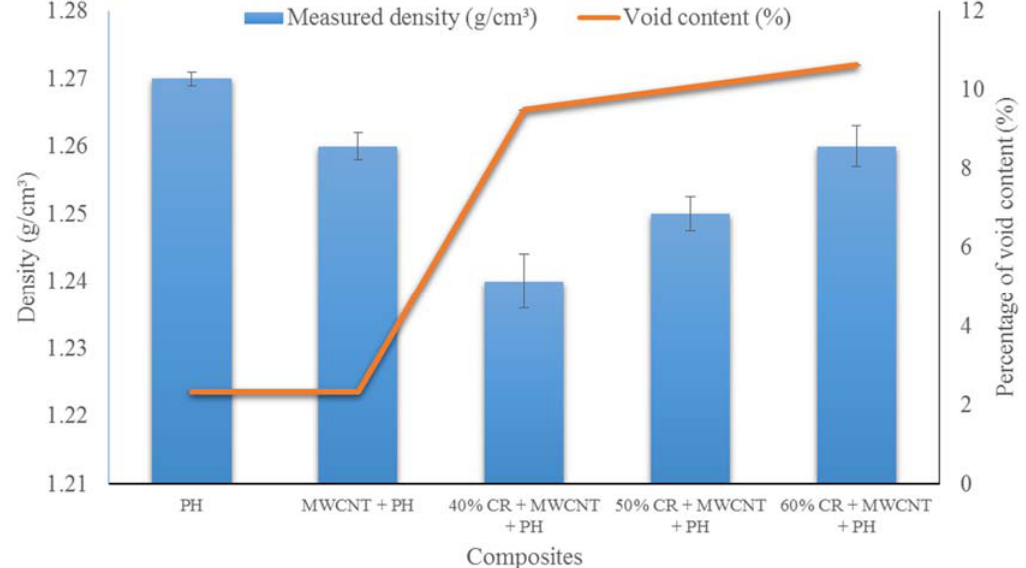
Figure 2. Density and voids content of CR fiber-reinforced MWCNT/phenolic composites.